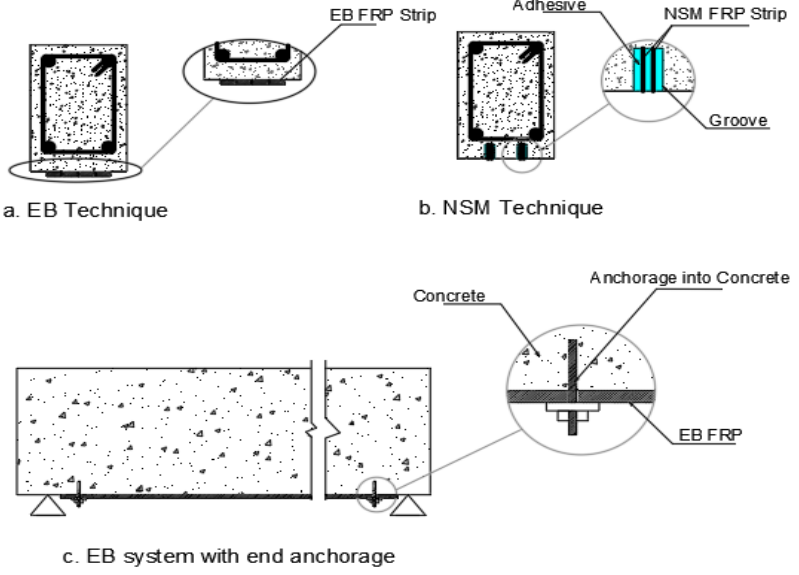
Figure 2. Flexural strengthening systems.